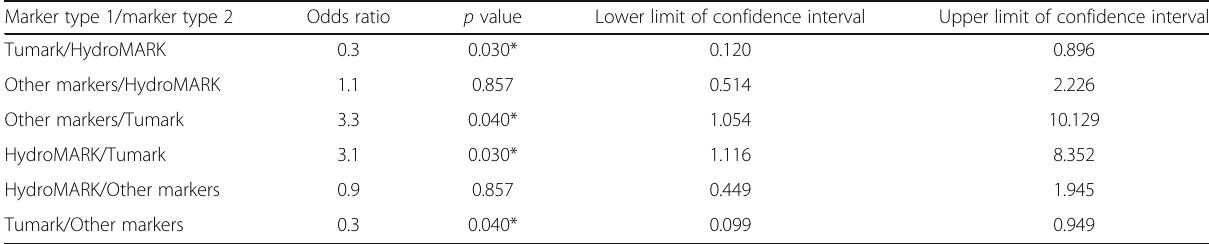
Table 1 Odds ratios for the visualization of various marker types with high confidence Marker type 1/marker type 2